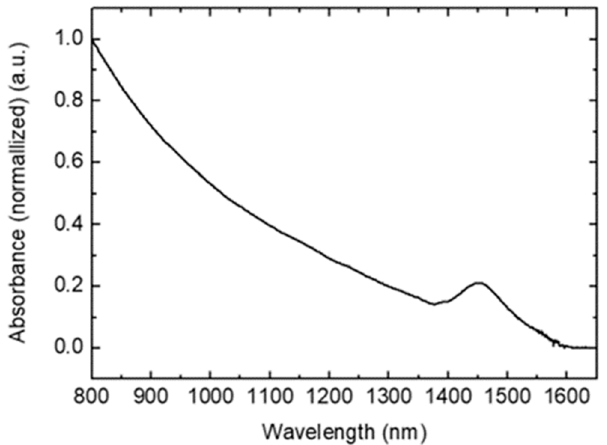
Figure 8. The absorbances of the aggregation-free cysteamine capped PbS quantum dot as synthesized. The absorbance of the quantum dot as synthesized is showing the peak wavelength of absorption at 1450 nm which is a good agreement with the theoretical works.